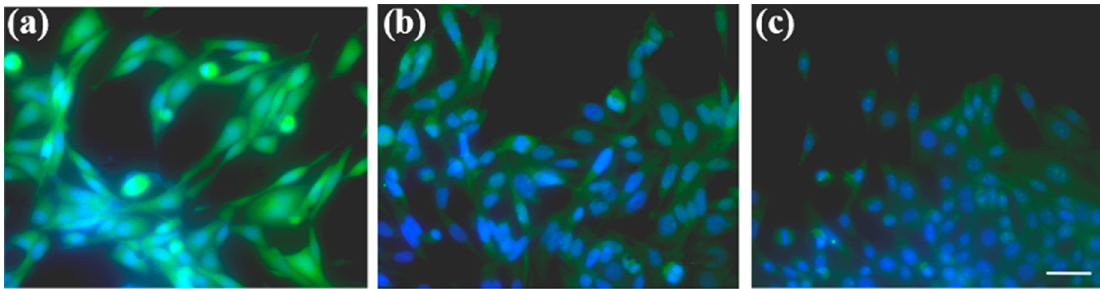
Figure 9. Average migration distances of tumor-induced HLF treated by gallic acid (GA) or baicalein (BAE) (* p < 0.05).